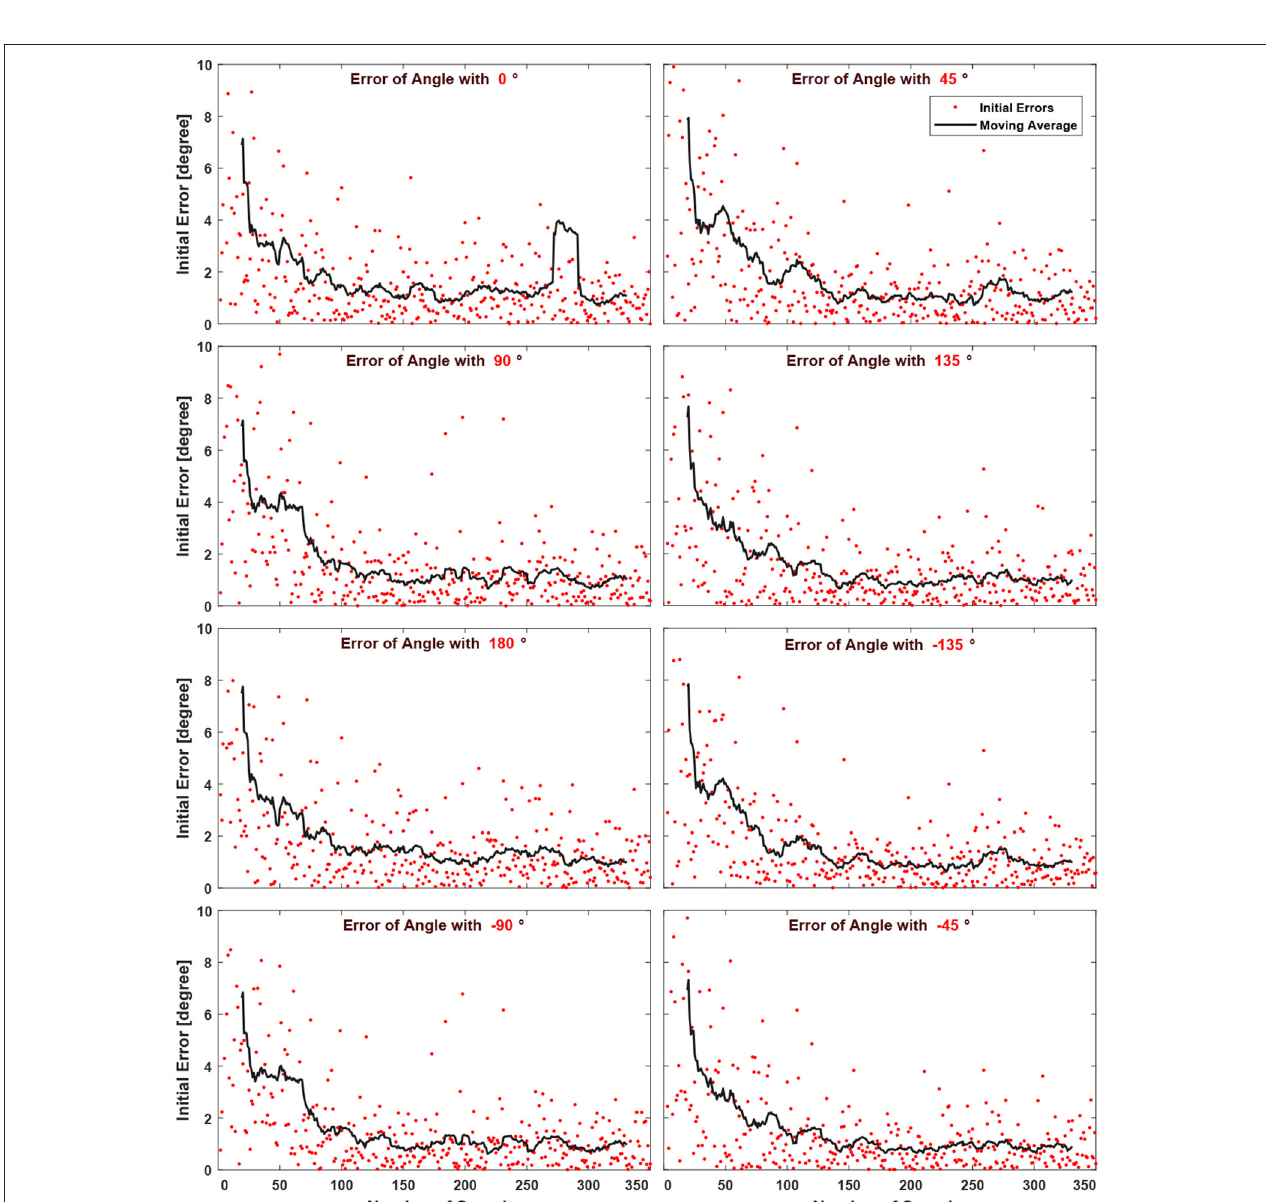
FIGURE 5 | The absolute error of early estimation (initial error) decreases with increasing samples for each desired line angle. Each sample represents a randomly selected arm configuration in the 2D workspace. The moving average, black line, in each figure further illustrates this effect.